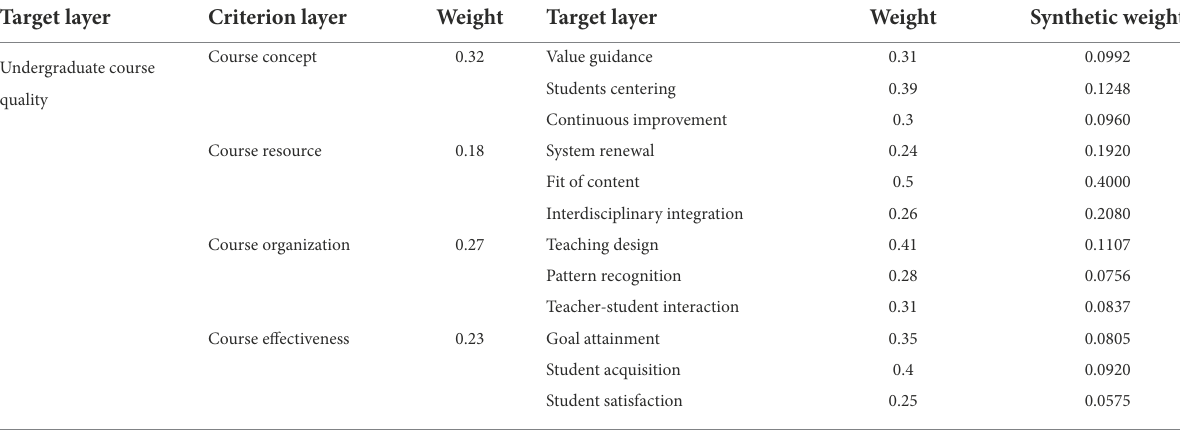
TABLE 4 Weight of each indicator of undergraduate course quality evaluation by